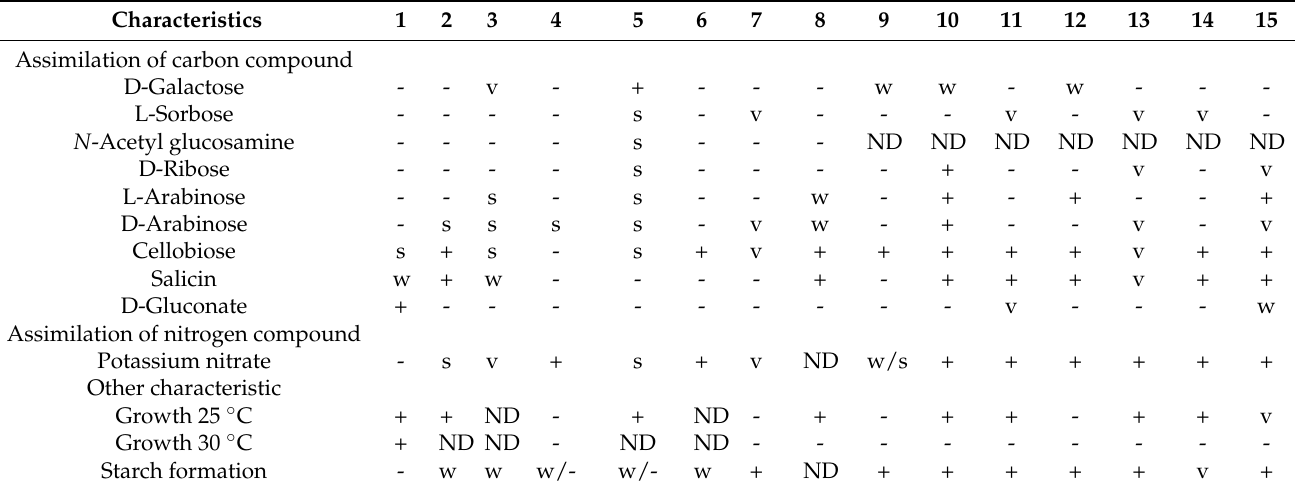
Table 4. Phenotypic characteristics that differentiate Savitreella phatthalungensis gen., sp. nov. from its closest species in the genera Protomyces and Taphrina